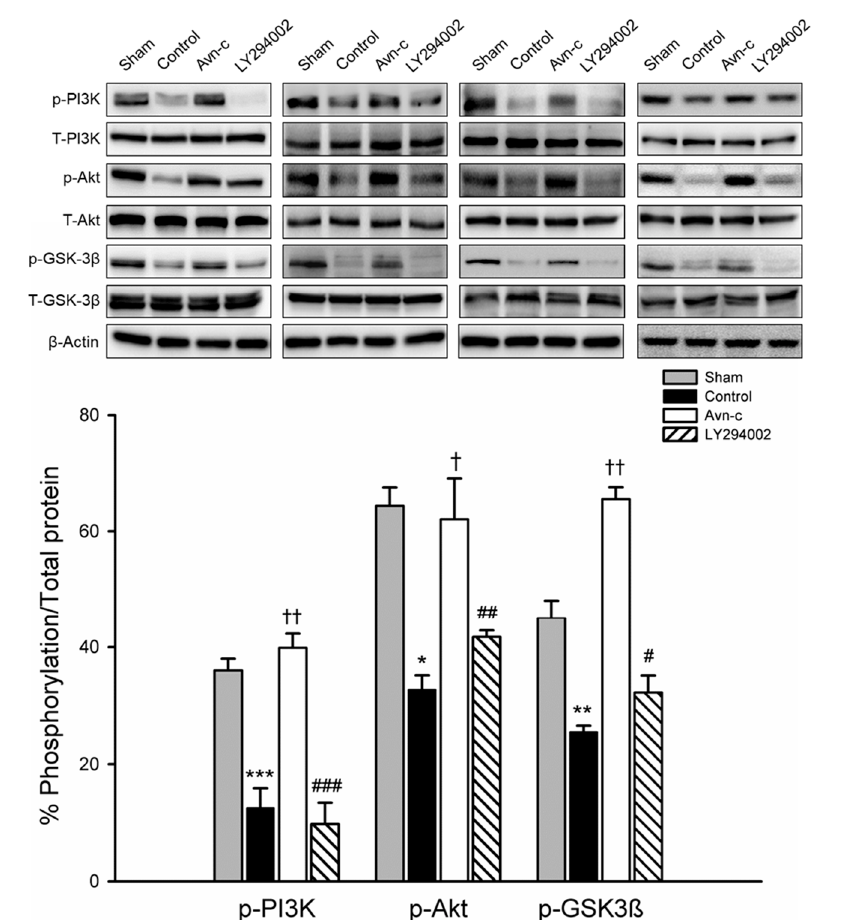
Figure 3. Avn-c prevents MCAo induced inhibition of the PI3K/Akt pathway. Expression of phosphorylated (p)-PI3K, p-Akt, and p-GSK3 β . Quantitative analysis of protein expression changes in different groups. The quantification of ZO-1, VE-cadherin and occludin protein expression. Data shown are mean ± SEM (data from 16 mice, n = 4). * p < 0.05, ** p < 0.01 and *** p < 0.001 vs. sham group. † p < 0.05 and †† p < 0.01 vs. control group. # p < 0.05, ## p < 0.01 and ### p < 0.001 vs. Avn-c group.